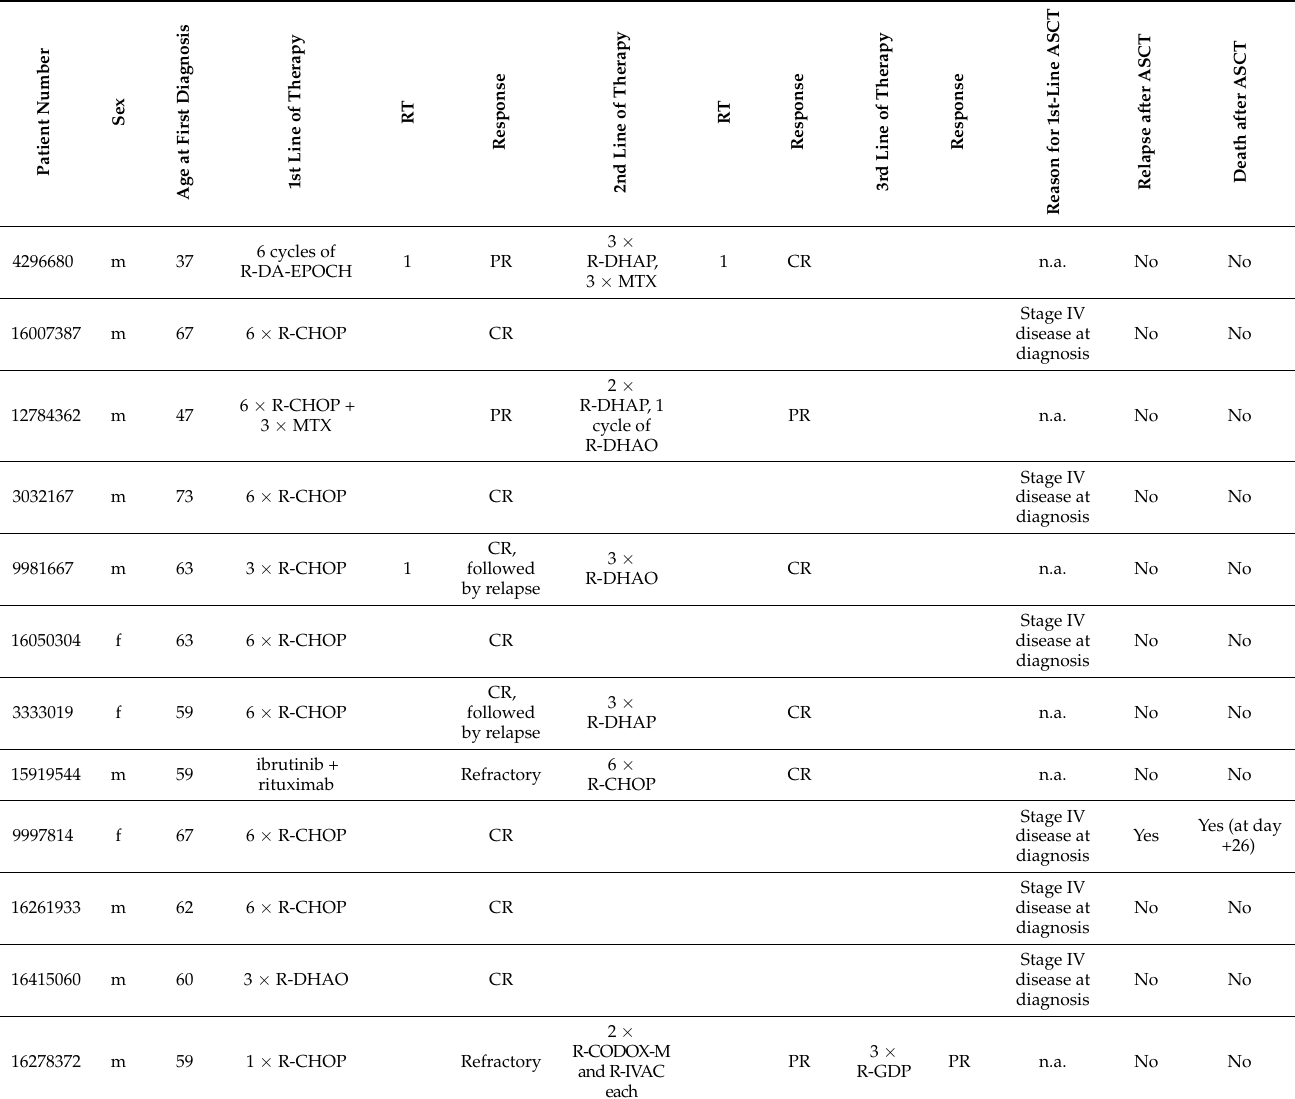
Table 2. Details on patients’ previous